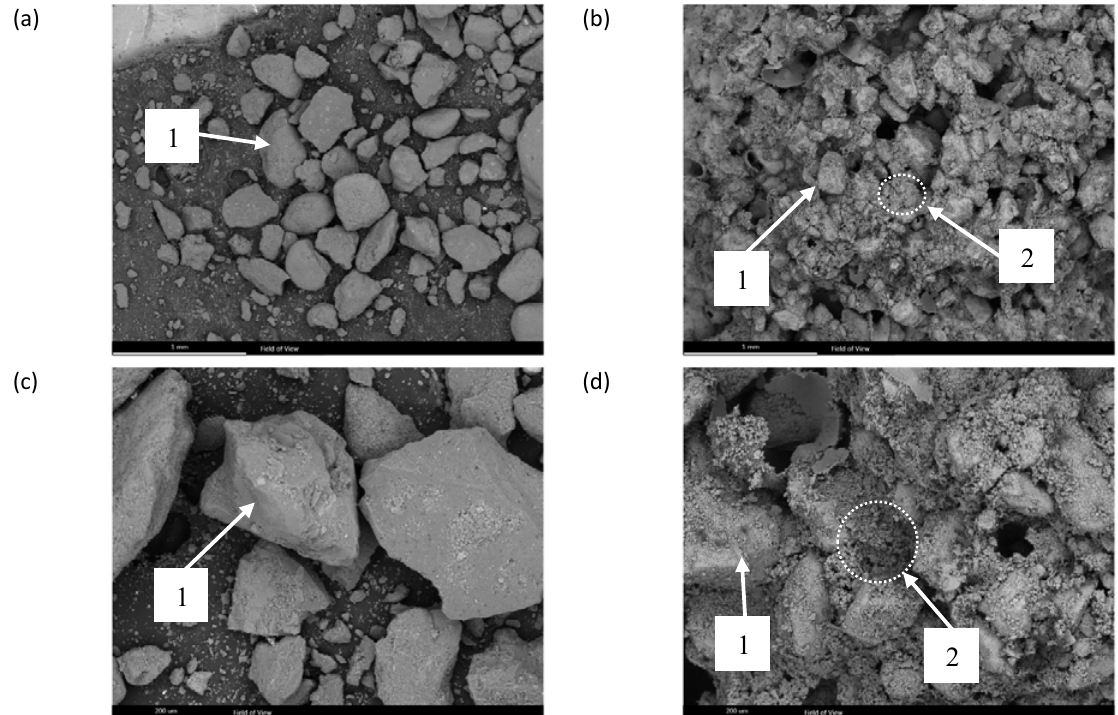
Fig. 9: SEM images of untreated (a,c), and treated T14 (b,d) soil samples (the magnification of each image is illustrated at its left bottom corner)